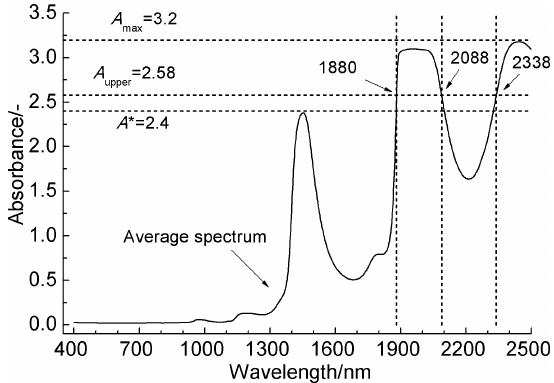
Fig. 4. Sketch map for the relationship between wavelength and absorbance.